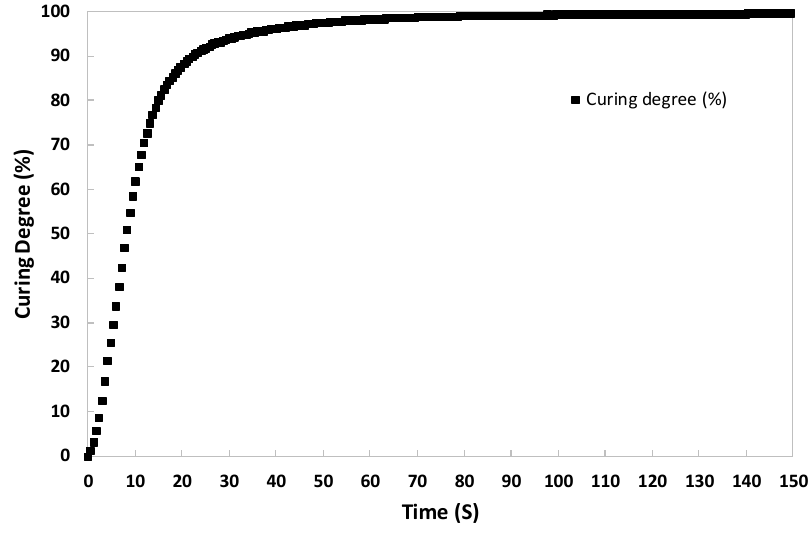
Figure 8. Curing degree ( ■ ) of the UV prepreg composed of 15 wt.% MAT225, calculated from parameters obtained by DEA.